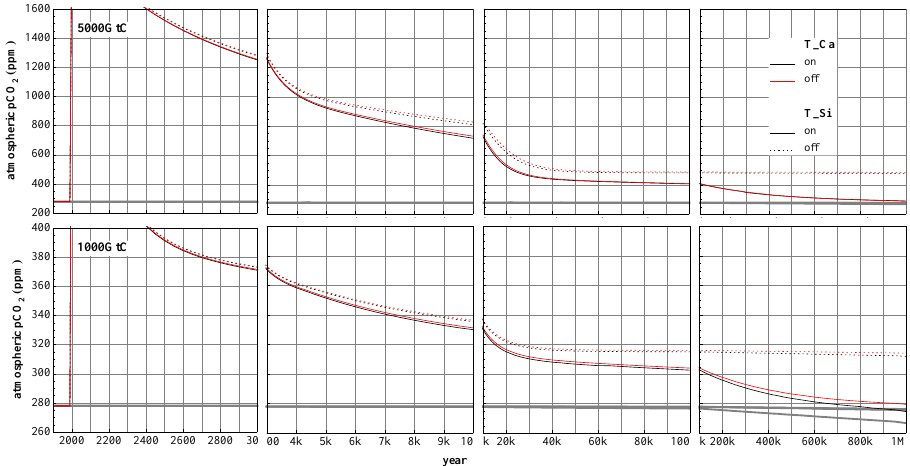
Fig. 6. Evolution of atmospheric CO 2 over 1Myr for 1000GtC (bottom) and 5000GtC (top) emissions pulses, vs. a control run with no emissions (grey lines), with carbonate and silicate weathering-temperature feedbacks (T_Ca and T_Si respectively) on/off.